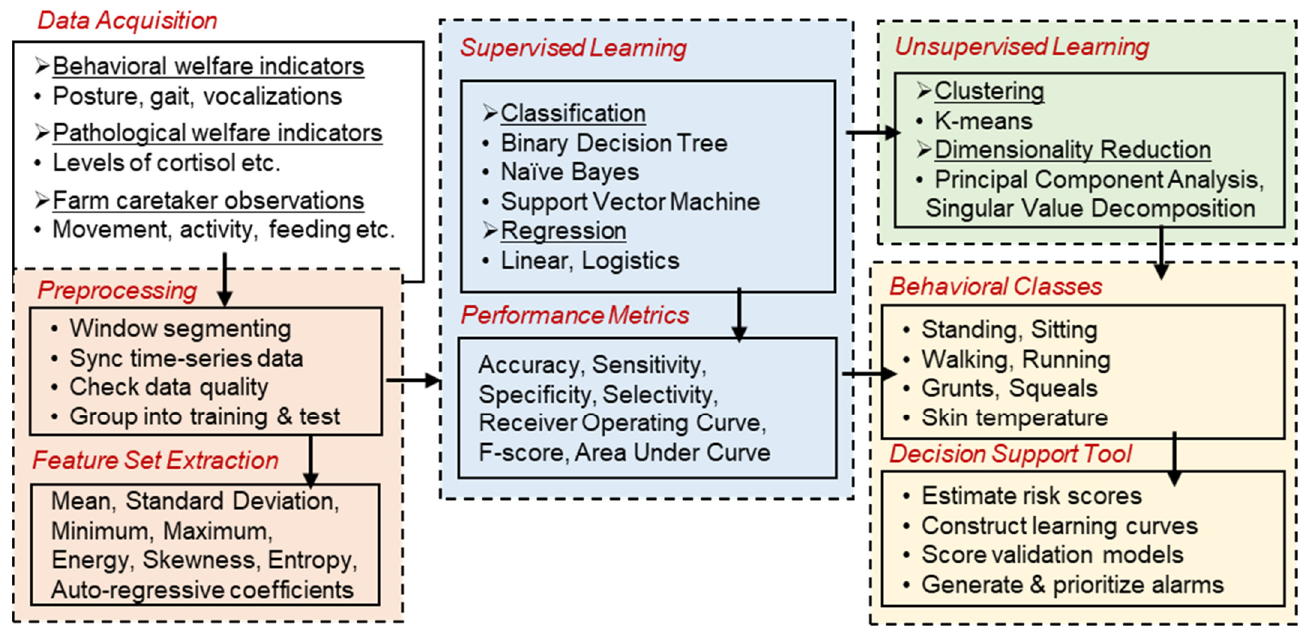
Figure 6. Process flow during machine intelligence involves data acquisition, preprocessing, feature set extraction, super- vised or unsupervised learning, class definitions, performance metrics, and decision support.